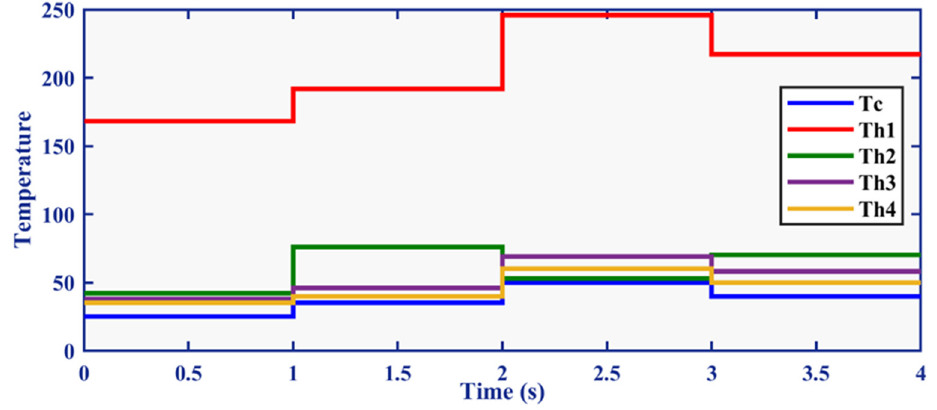
Figure 9. Temperature variation in Case 2.